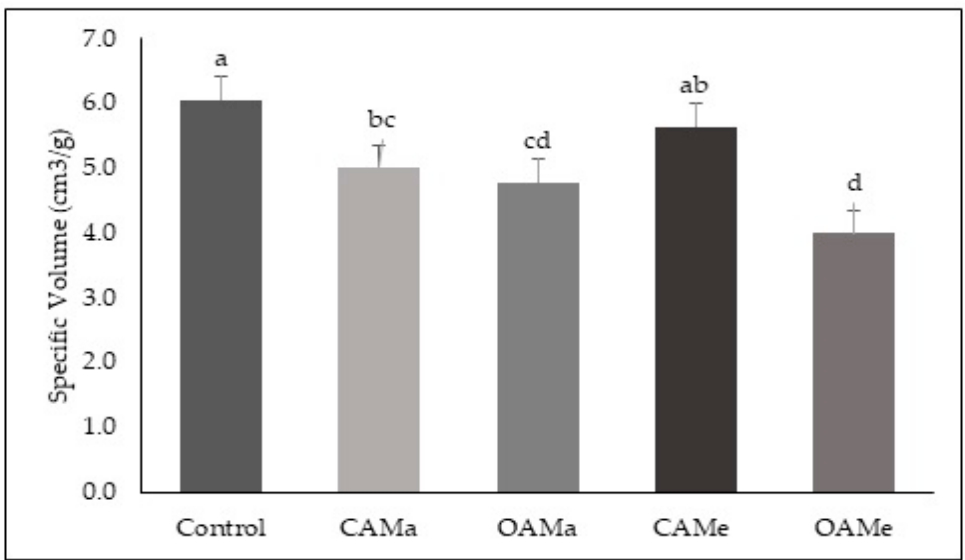
Figure 1. Specific volume of muffin. Different letters in the same graphics indicate significant differences ( p < 0.05).